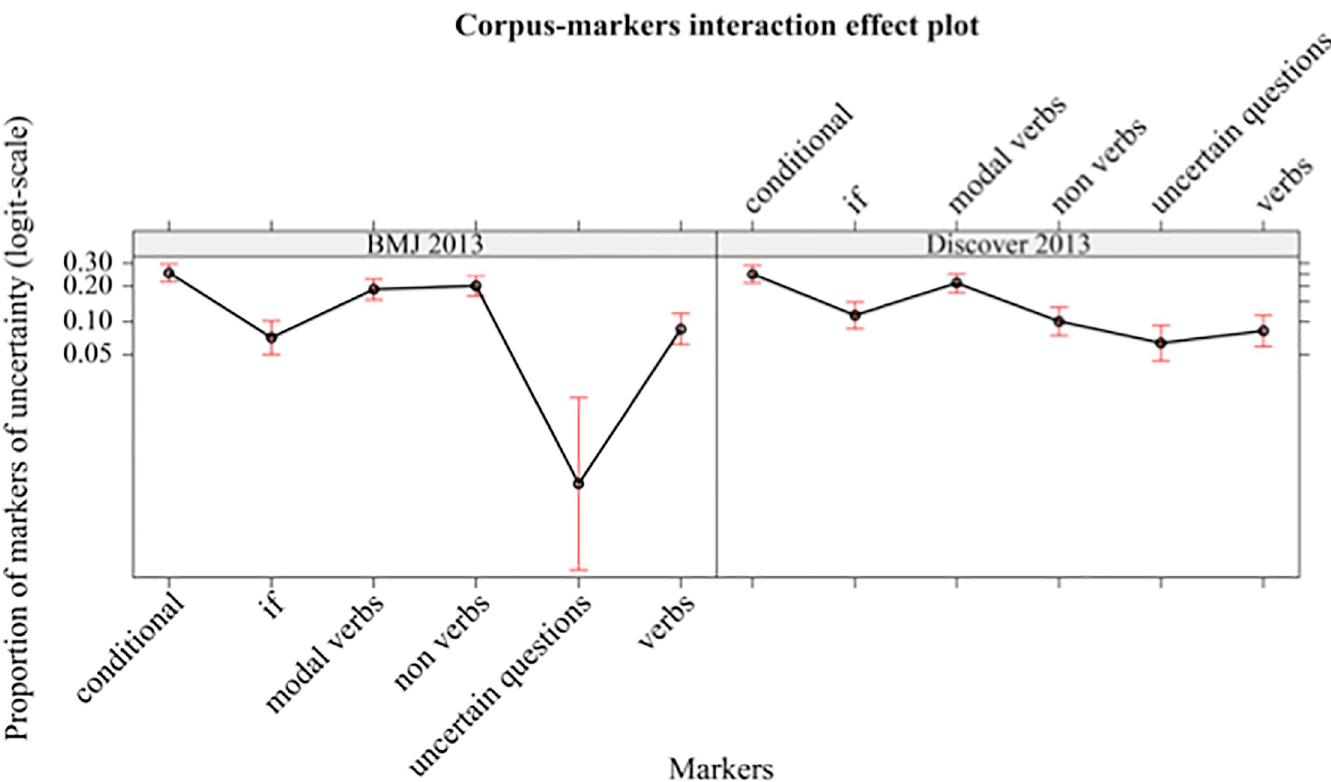
Fig 9. Mean proportions (95% confidence interval) of markers of uncertainty (in logit-scale) of different markers (conditional, if, modal verbs, non-verbs, uncertain questions, verbs), separately by corpus (BMJ 2013, Discover 2013).